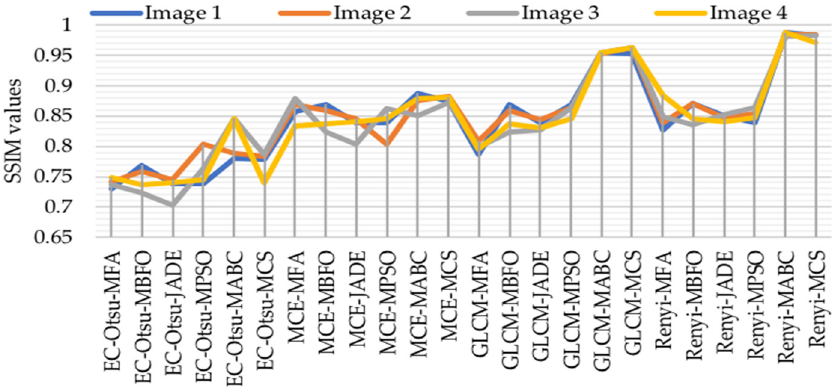
Figure 22. Results of SSIM values for all algorithms at level 8.